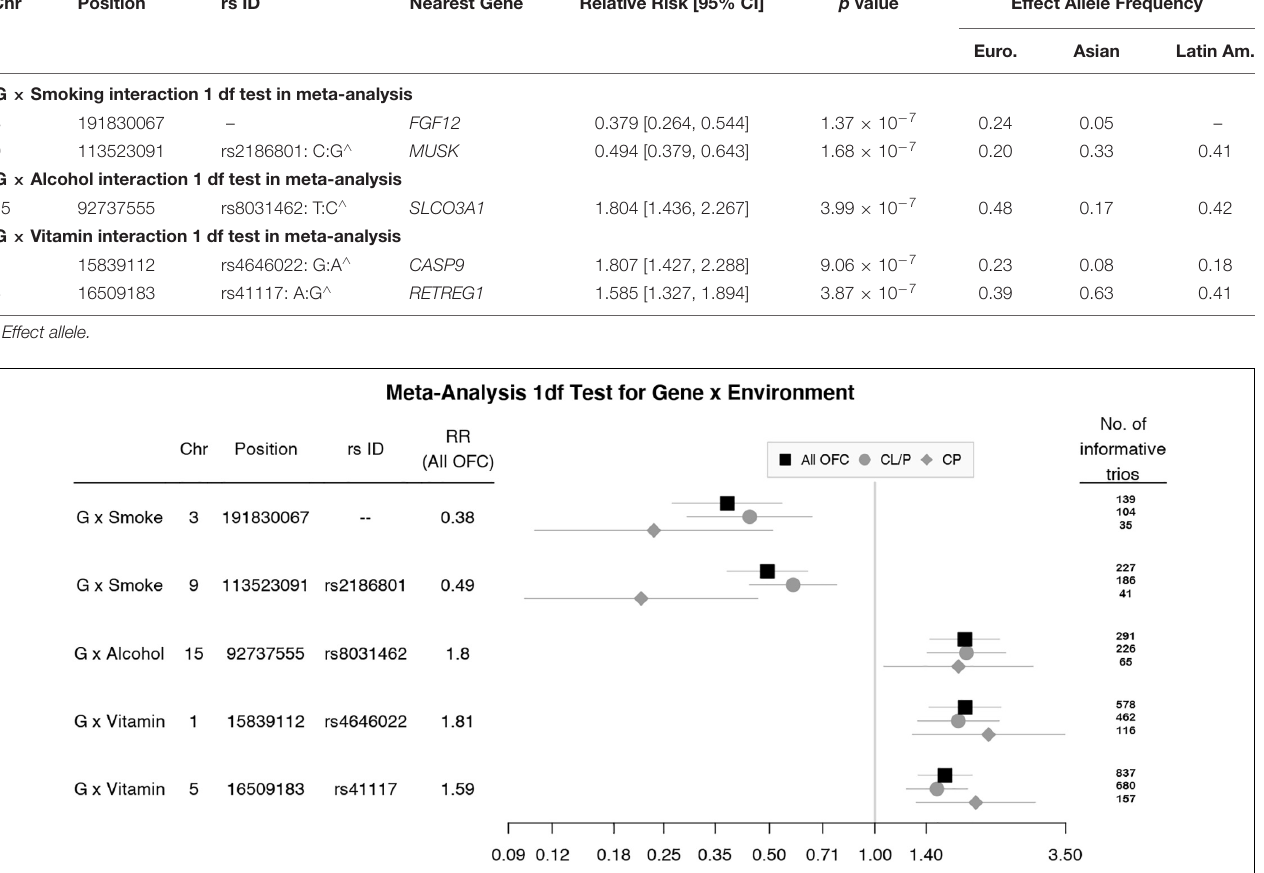
FIGURE 4 | Estimated relative risks (RR) and 95% CI for SNPs listed in Table 2 from the 1 df test of G × E interaction in meta-analysis of all OFC trios (black squares) and stratified analysis of CL/P (gray circles) and CP trios (gray